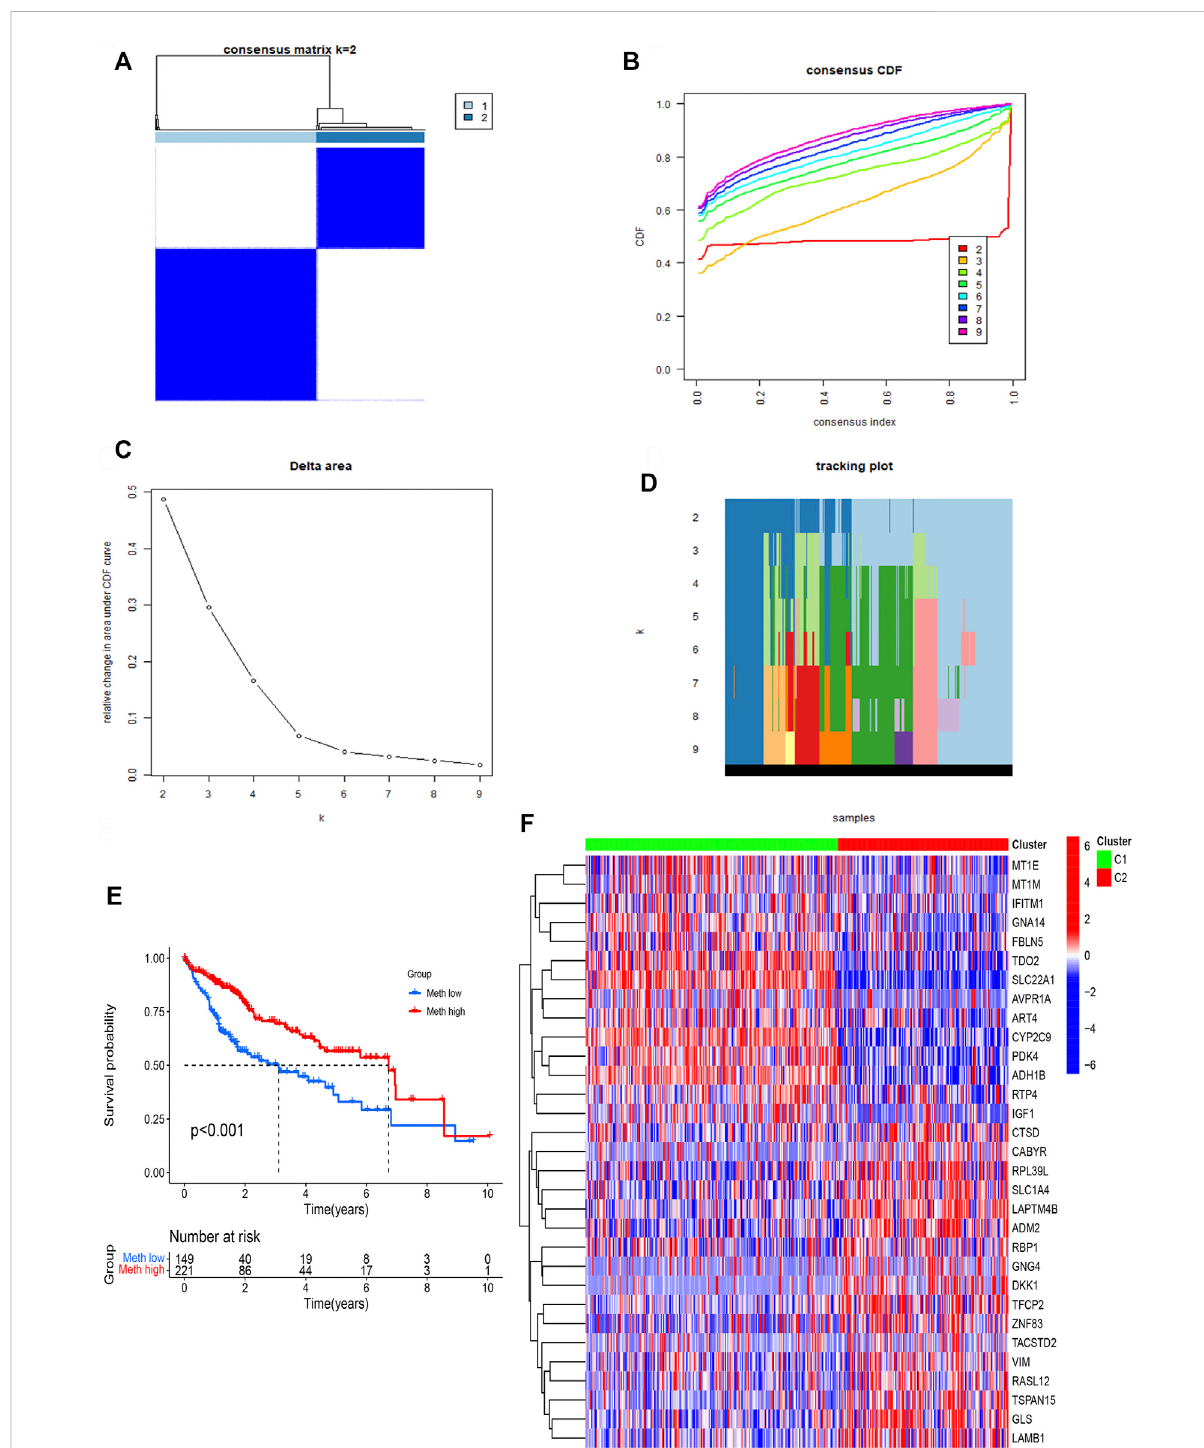
FIGURE 3 Identi fi cationoftwosubtypes basedon Consensus clustering analysis. (A) Consensusclustering at k =2. (B) EmpiricalCDF plotscorresponding to each k. (C) Delta area diagram at different k. (D) Item tracking plot at each k. (E) Survival analysis of HCC patients in two subtypes. (F) The heatmap of 31 DNA methylation-driven genes in two